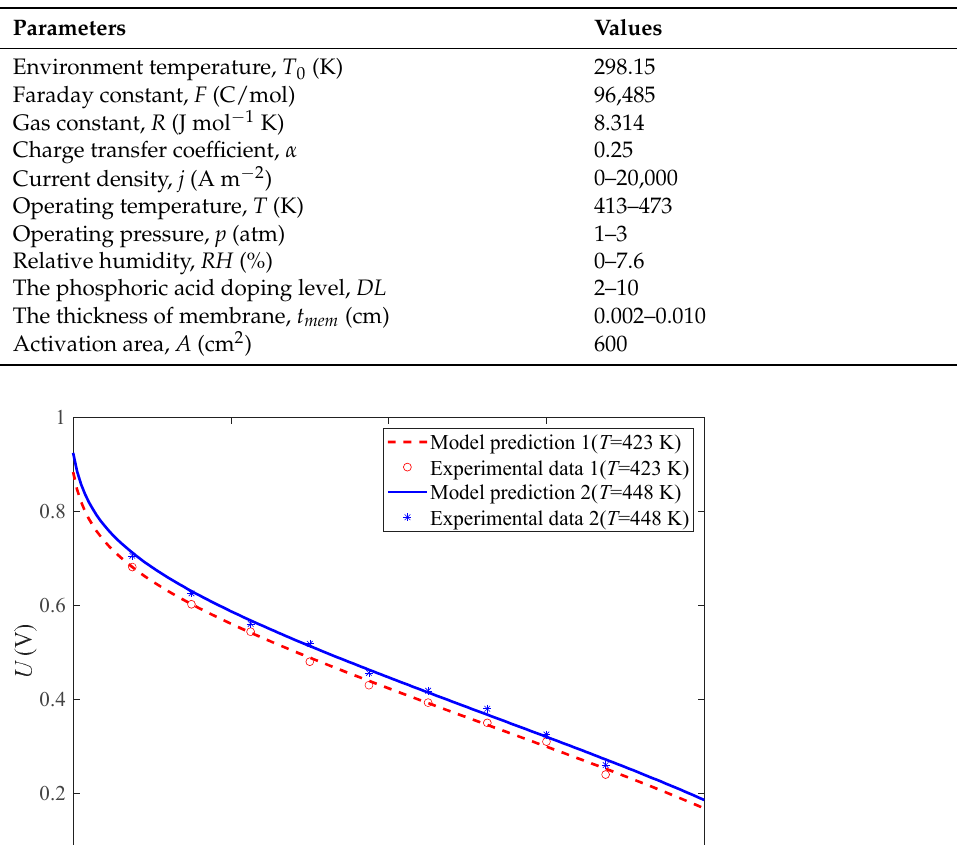
Table 1. Parameters of HT-PEMFC model.